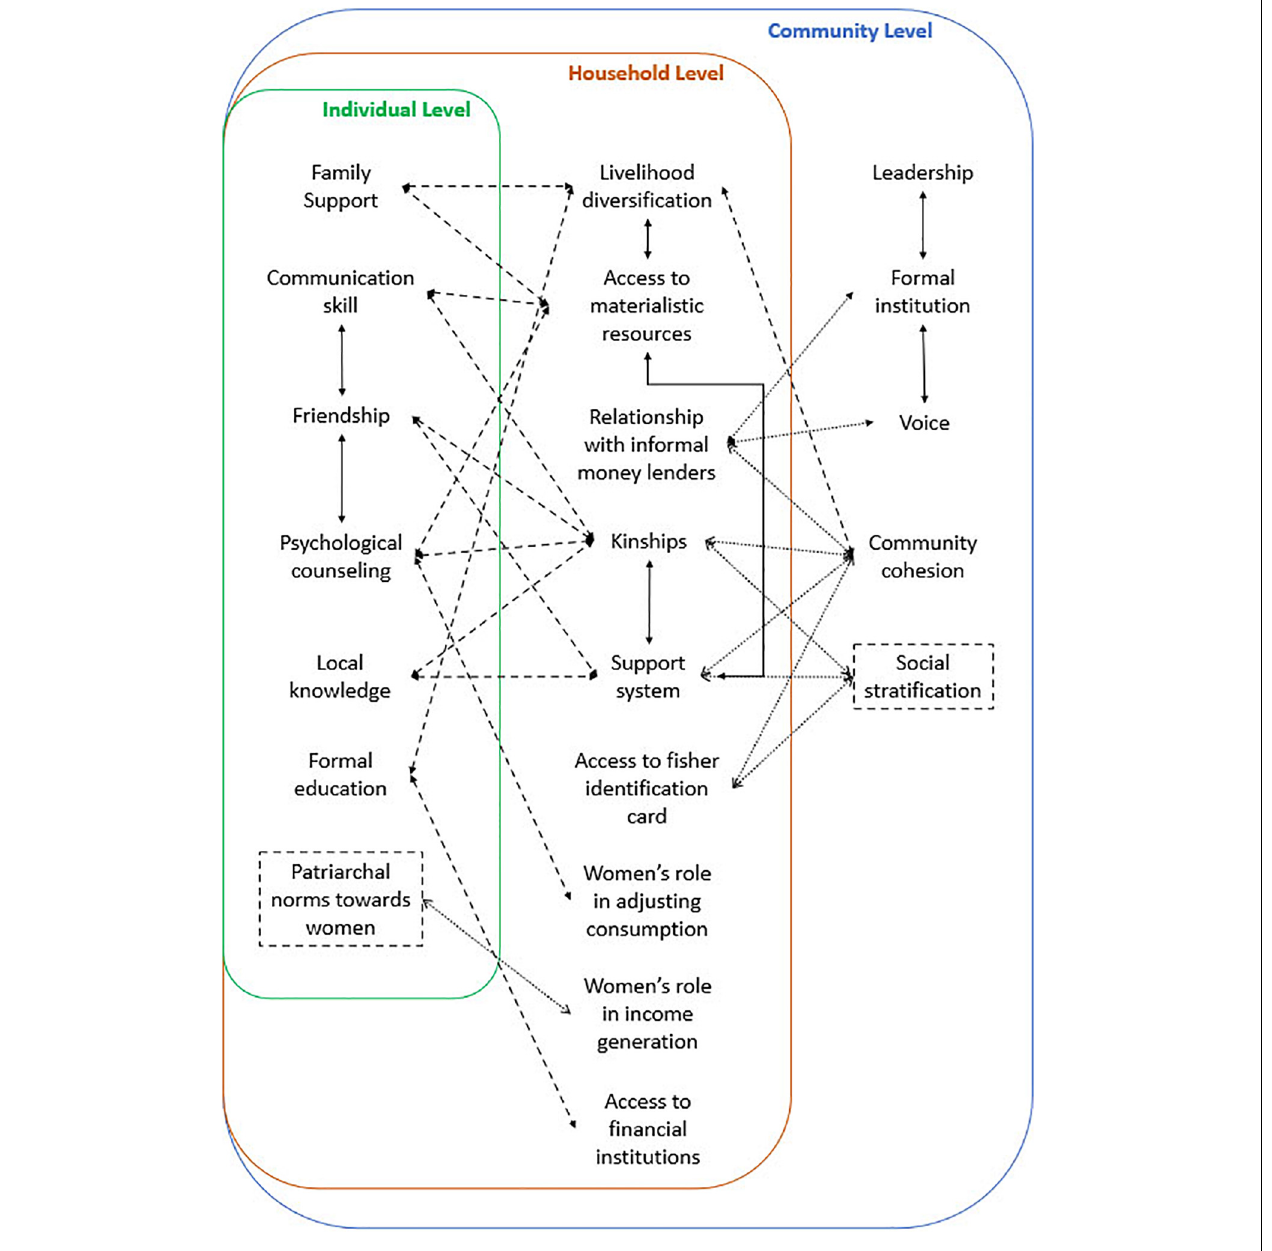
FIGURE 2 | Interactions between individual, household, and community level resilience features. Dashed boxes represent features that decreased level resilience. Dashed arrows represent positive and dotted arrows represent negative interactions between levels. Solid arrows represent interactions within the same